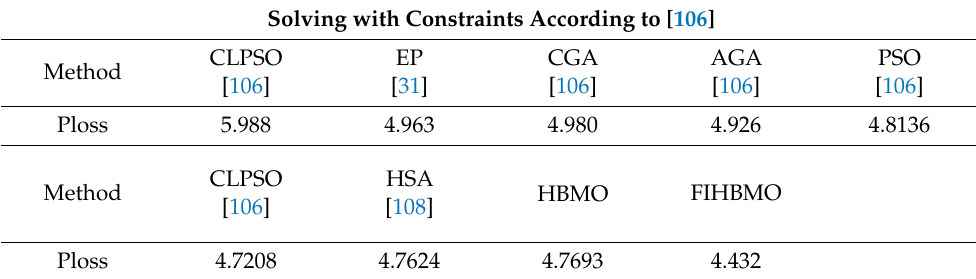
Table 3. Comparison of the proposed method with the literature results. Reproduced from [106], Elsevier: